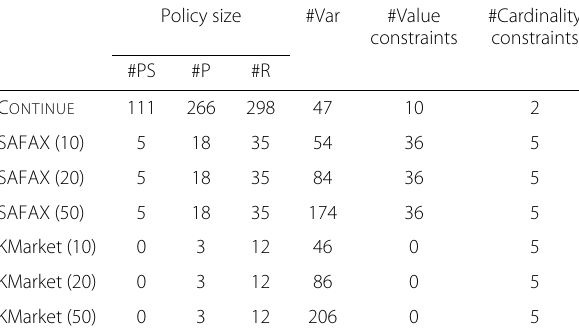
Table 5 Overview of the datasets used for the experiments Policy size #Var #Value #Cardinality constraints